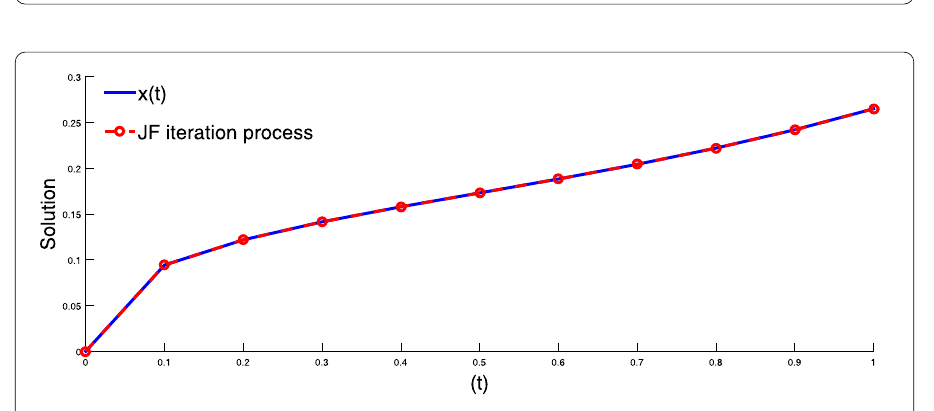
Figure 6 Graphical representation of exact solution and approximated solution of problem (6.3) by using the JF iteration process at k =